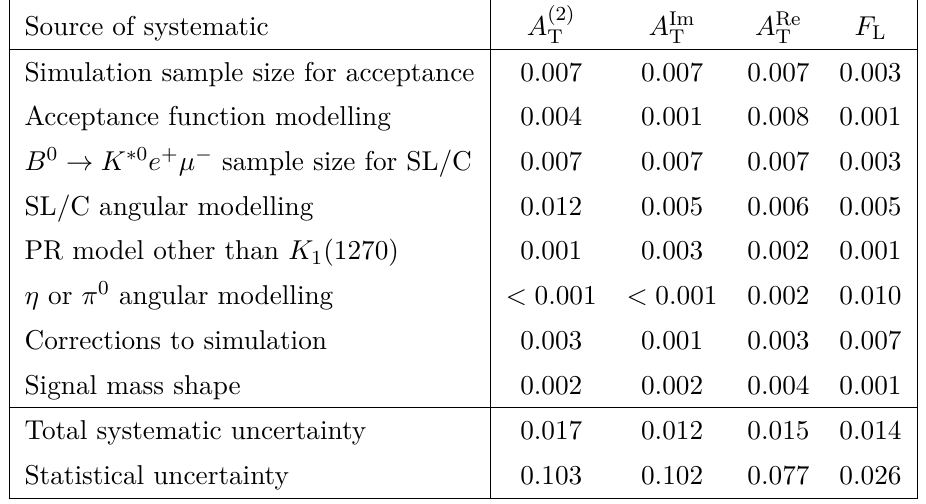
, A Im , A Re T T T